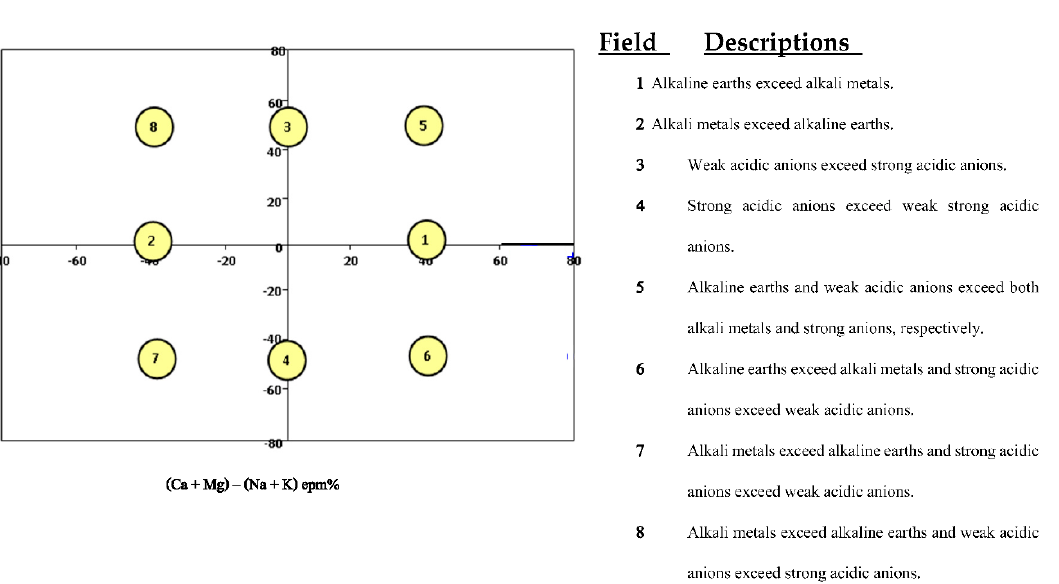
Figure 4. Gibbs Diagram for cations and anions in the study area . 2.10. Groundwater Level Fluctuation